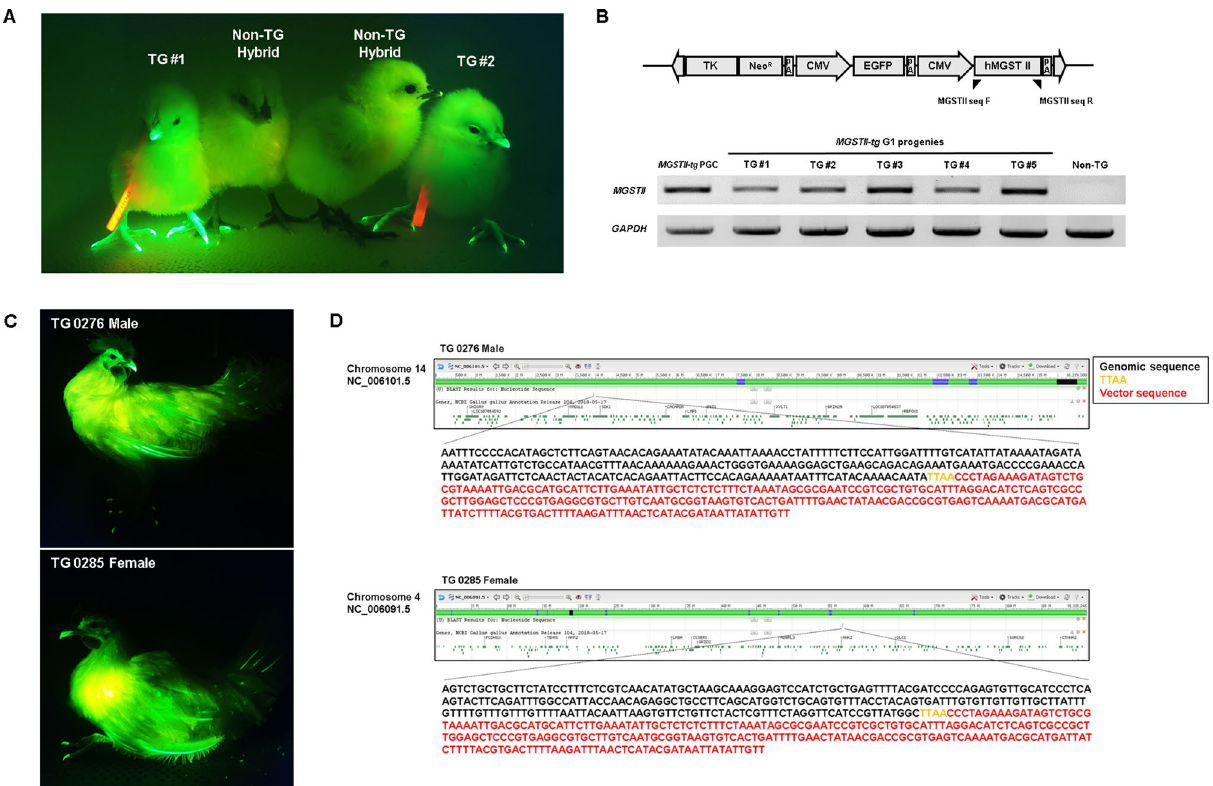
Figure 3. GFP expression in of MGSTII-tg chicks and identification of transgene insertion sites. ( A ) Donor MGSTII-tg PGCs-derived chicks. GFP-expressing chicks were distinguishable from non-transgenic hybrids using a fluorescent excitation lamp fitted with the appropriate filters. ( B ) Screening of MGSTII-tg chicks via genomic DNA PCR analysis. Genomic DNA PCR analysis of transgenic G 1 chicks using MGSTII - and GAPDH- specific primers. MGSTII-tg PGCs and non-tg genomic DNA samples were used as positive and negative controls, respectively. ( C ) Detection of GFP expression in adult TG chickens (20 weeks) in both male (TG 0276) and female (TG 0285) animals using a fluorescent excitation lamp fitted with the appropriate filters. ( D ) Identification of the transgene integration site in transgenic chickens. The transgene was integrated into the intergenic region of chromosome 14 in TG 0276, and into the intergenic region of chromosome 4 in TG 0285. Black color nucleotides indicate genomic DNA sequences, yellow color nucleotides indicate transposon recognition sequences (TTAA), and red color nucleotides indicate the 5 ′ of piggyBac vector